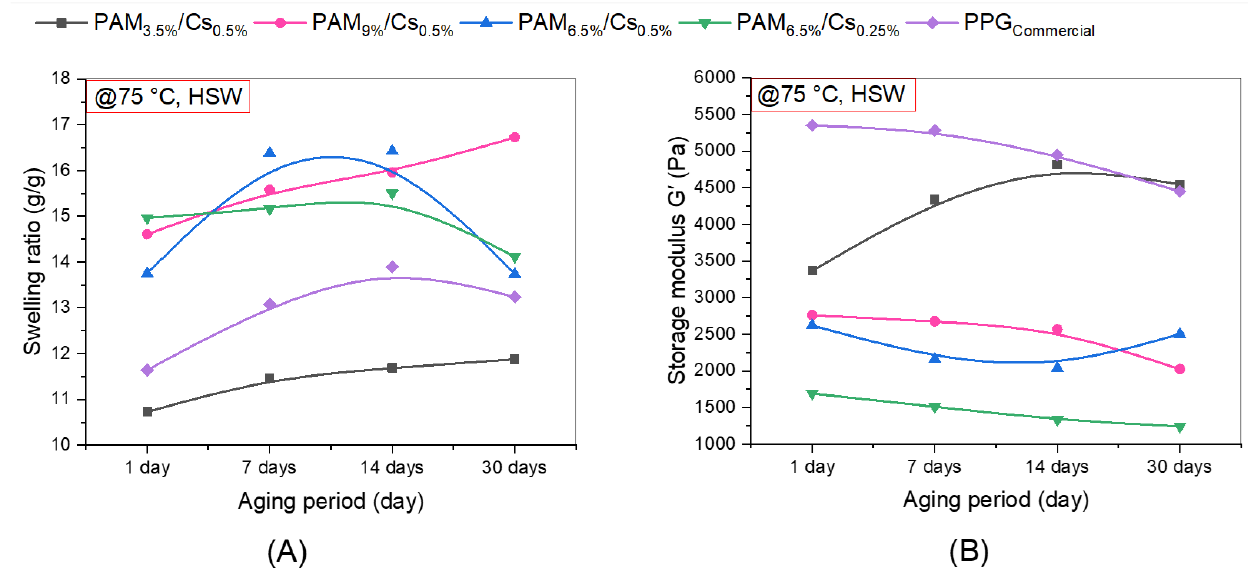
Figure 13. Aging effect on the ( A ) swelling and ( B ) strength of PAM/Cs PPGs and a commercial PPG at 75 °C in HSW.